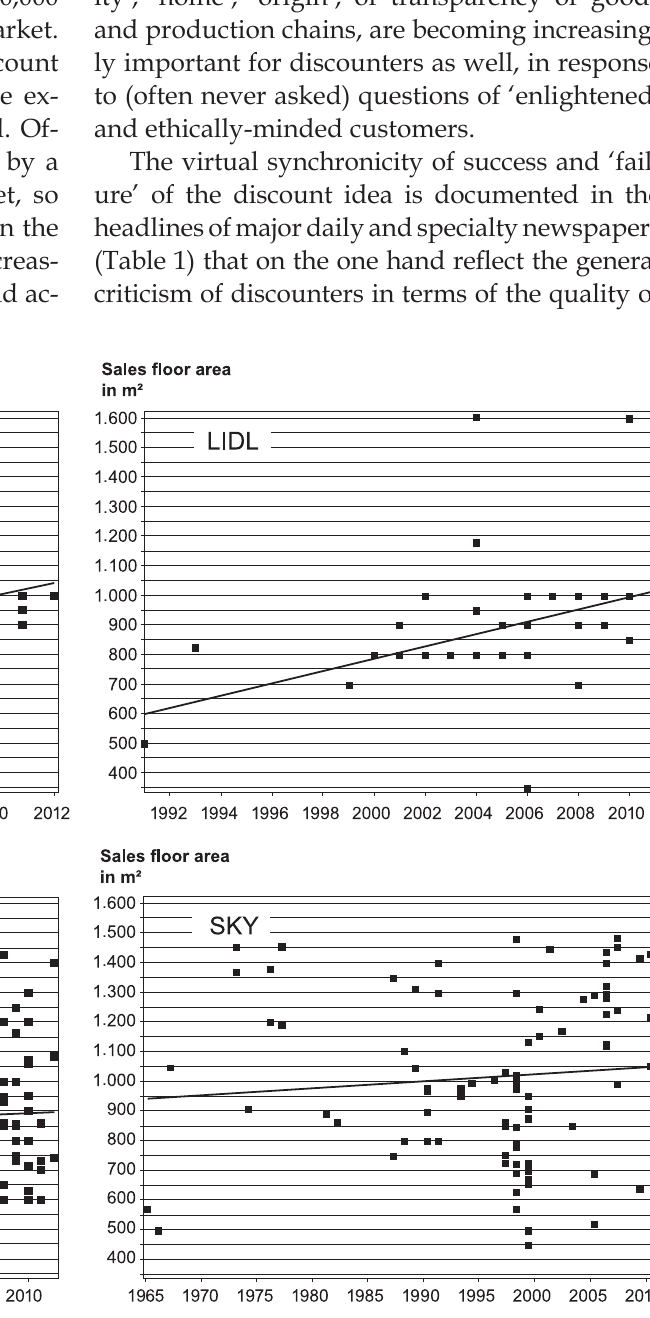
Fig. 1. Dynamics of the sales floor area in German discounter and supermarket chains in the province of Schleswig-Holstein, Germany. Source: Nielsen Company 2011, own calculations by